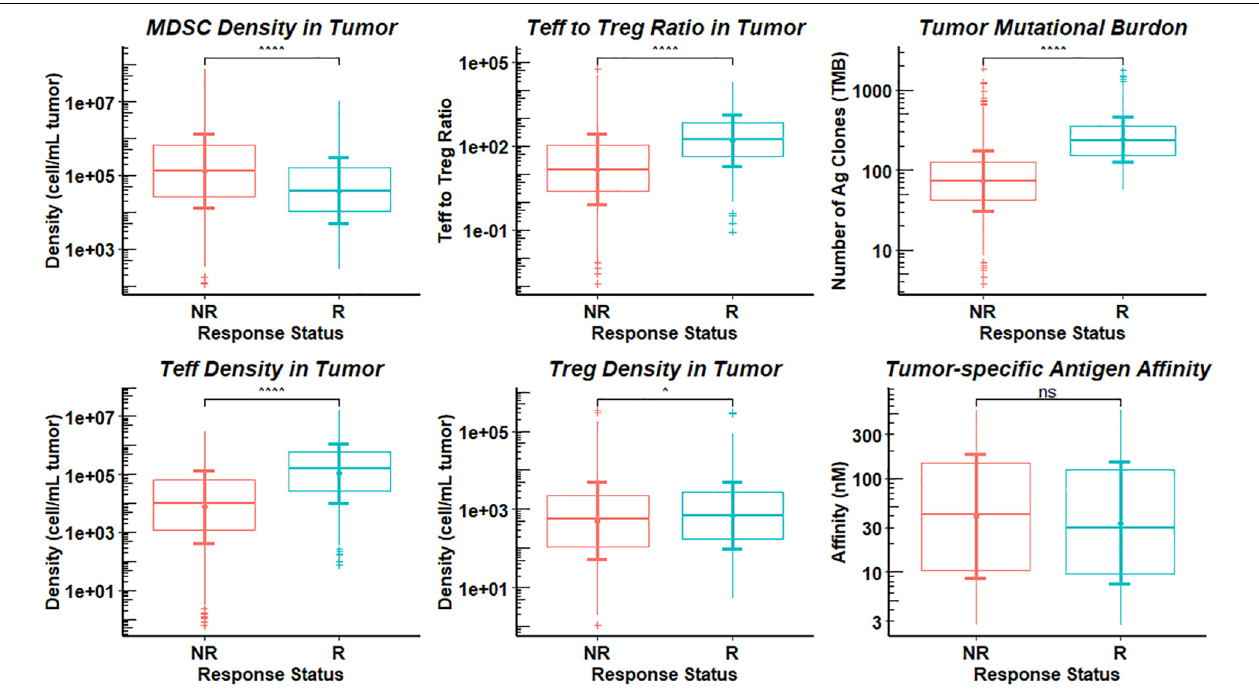
FIGURE 9 | Distributions of Potential Biomarkers in Responders and Non-responders. The response in the 1196 simulations was divided into responders (R) and non-responders (NR), and statistical comparisons are presented between the two groups for pre-treatment observations. Statistical significance is calculated by Wilcoxon test. ∧ p -values ≤ 0.05; ∧∧∧∧ p -values ≤ 0.0001; non-significance (ns), p -values >